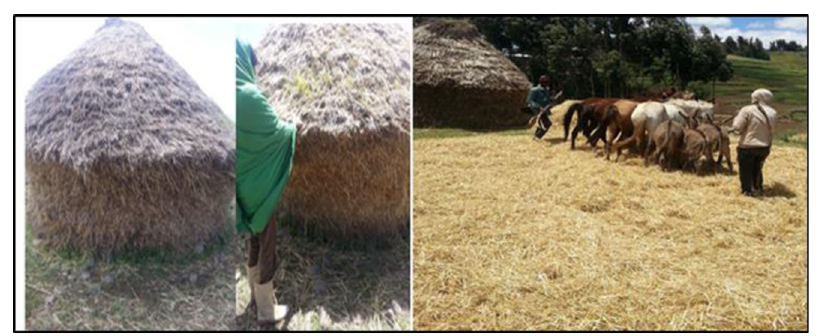
Fig 5. Traditional field storage and threshing practice of barley landraces and its side